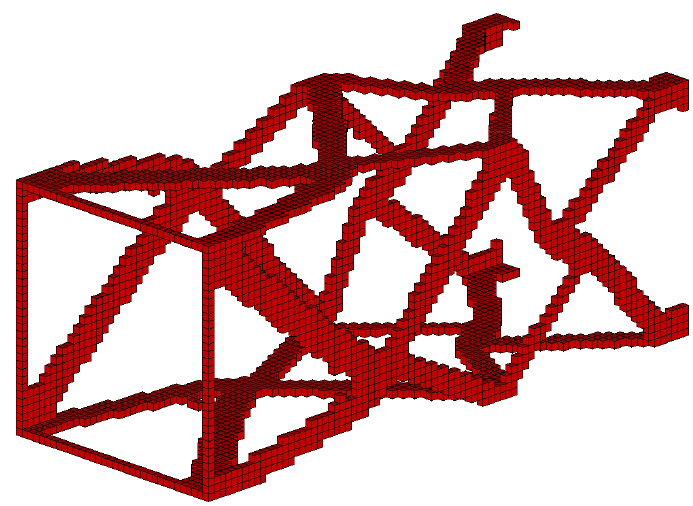
Figure 30. The final topology for the box tube for volume fraction 𝜅 = 0.25 .